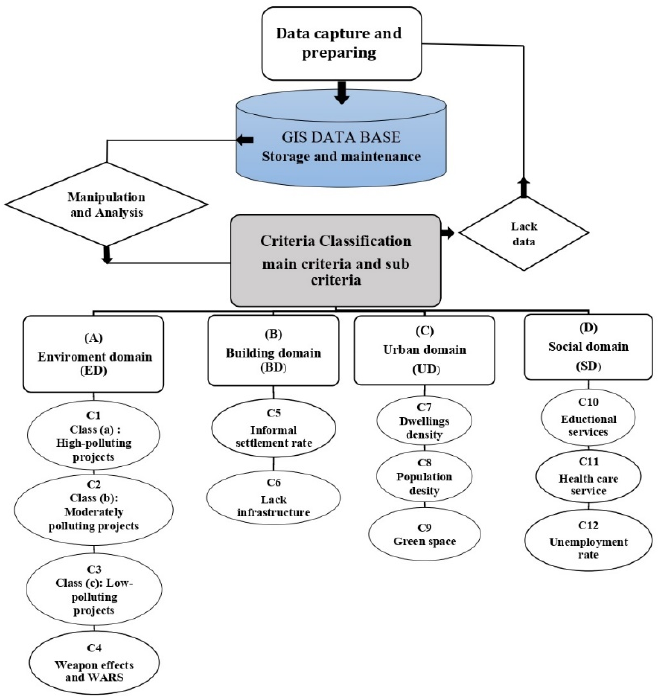
Figure 3. Flowchart of data collection and classification of the criteria and sub-criteria.